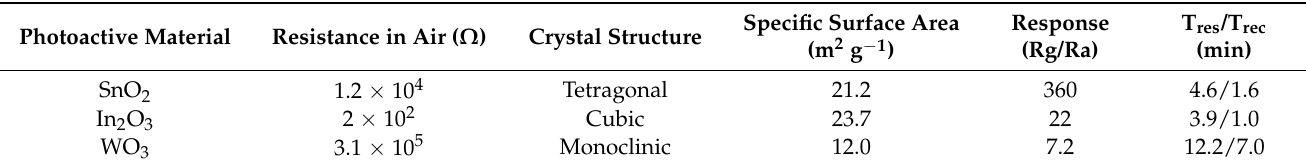
Table 1. Typical sensing characteristics of representative sensors to 5 ppm NO 2 at 30 ◦ C in dry air under UV light irradiation (365 nm) of 7 mW cm − 2